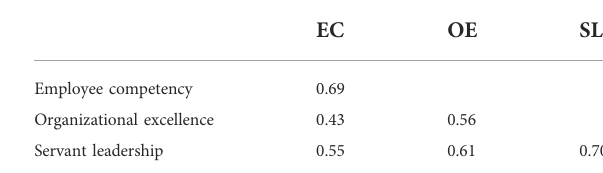
TABLE 3 Fornell – Larcker criterion